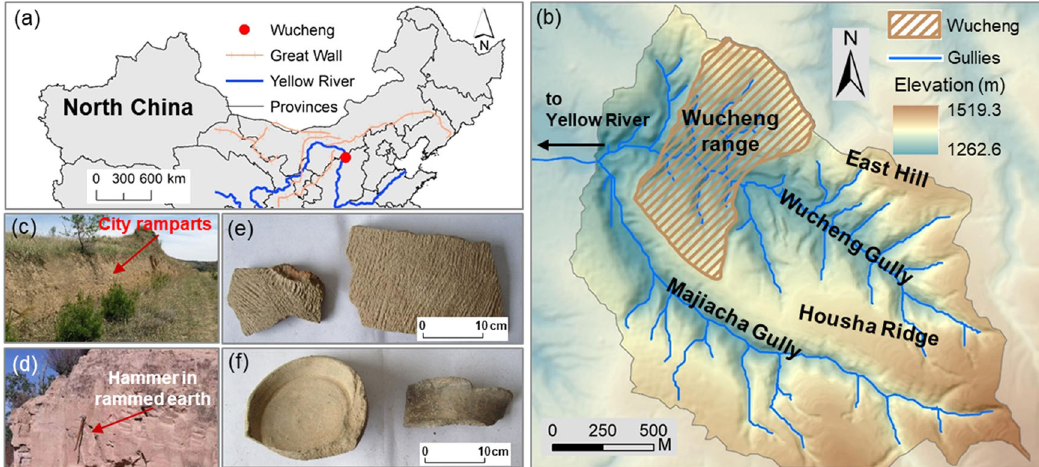
Fig. 1 Archaeological ruins of Wucheng city in China. a Location of the archaeological city; it is near the Yellow River and the Great Wall of the Qin-Han Dynasty of China; b detailed surveyed range of the archaeological city and its surrounding geomorphological background; c ancient Wucheng city ramparts; d city rampart constructed by rammed earth; e , f pottery tablets with rope veins from the Han Dynasty discovered in Wucheng. The ramparts were built on a Neolithic settlement lime layer, which can still be found in some places in the northwestern corner of the